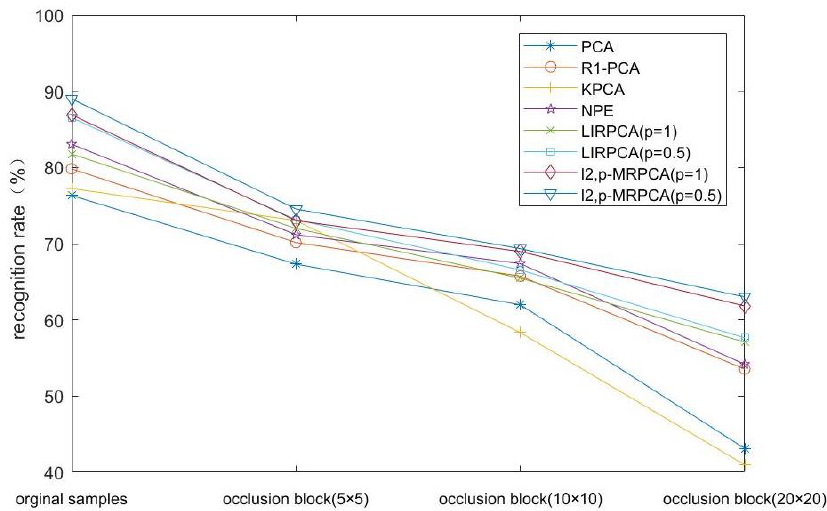
Figure 7. Classification recognition rate of PCA, 𝑅 1 -PCA, KPCA, NPE, LIRPCA ( 𝑝 = 0.5 ), LIRPCA ( 𝑝 = 1 ), 𝑙 2,𝑝 -MRPCA ( 𝑝 = 0.5 ), 𝑙 2,𝑝 -MRPCA ( 𝑝 = 1 ) on the PolyU palmprint database . ( p = 1), l = 0.5), l = 1) on the PolyU palmprint 2, p -MRPCA ( p 2, p -MRPCA ( p